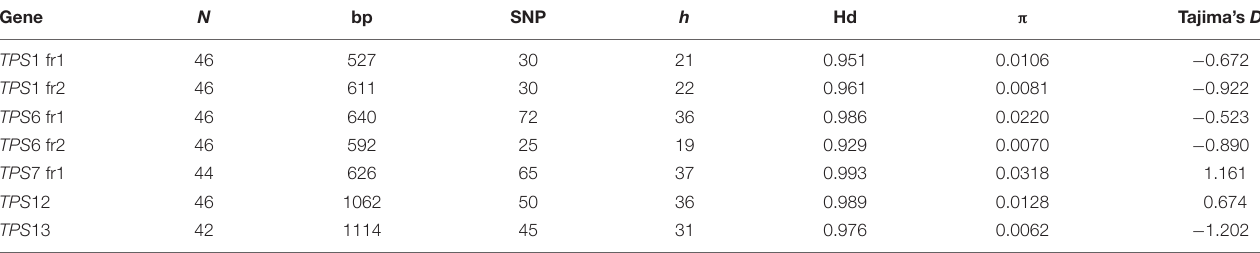
TABLE 1 | Allelic variation of the terpene synthase genes in the populations “BB1” and “R45.” Gene N bp SNP h Hd π Tajima’s